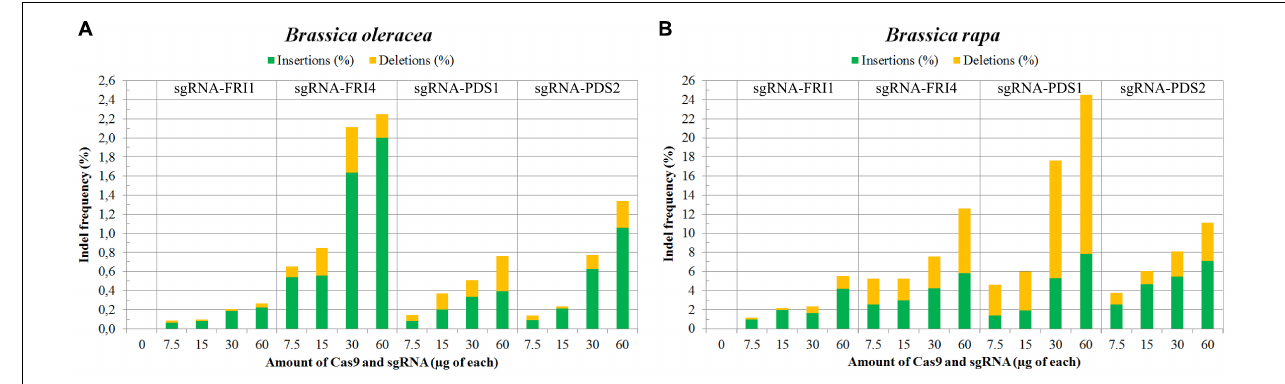
FIGURE 2 | Mutation frequencies in B. oleracea (A) and in B. rapa (B) measured by targeted deep sequencing and Cas-Analyzer. Percentages of induced insertions and deletions are represented in green and yellow, respectively.